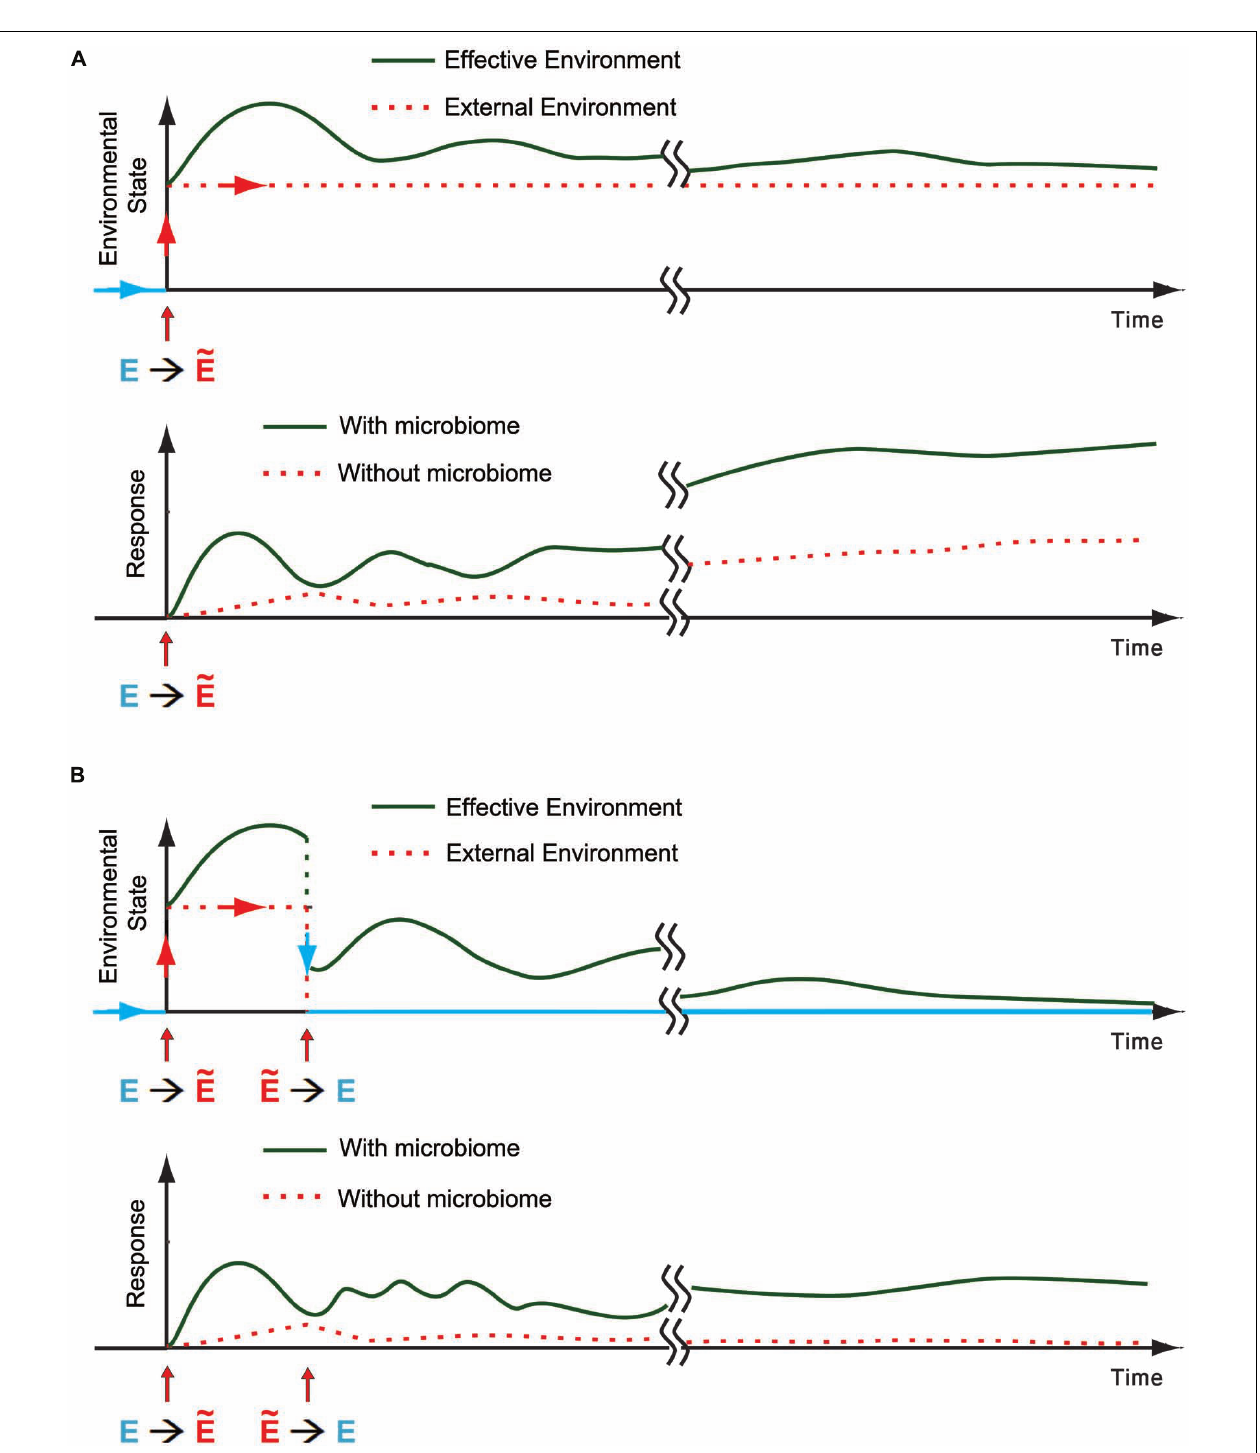
Bottom: Schematic representation of a potential host response with and without contribution of microbial disruption by the external environment (green and dotted red, respectively). Disruption of the microbiome can increase the response of the host, leading to a potentially faster and more pronounced response which is also more diverse and affects more individuals. (B) Same as (A) when the environment reverts back (˜E → E) within